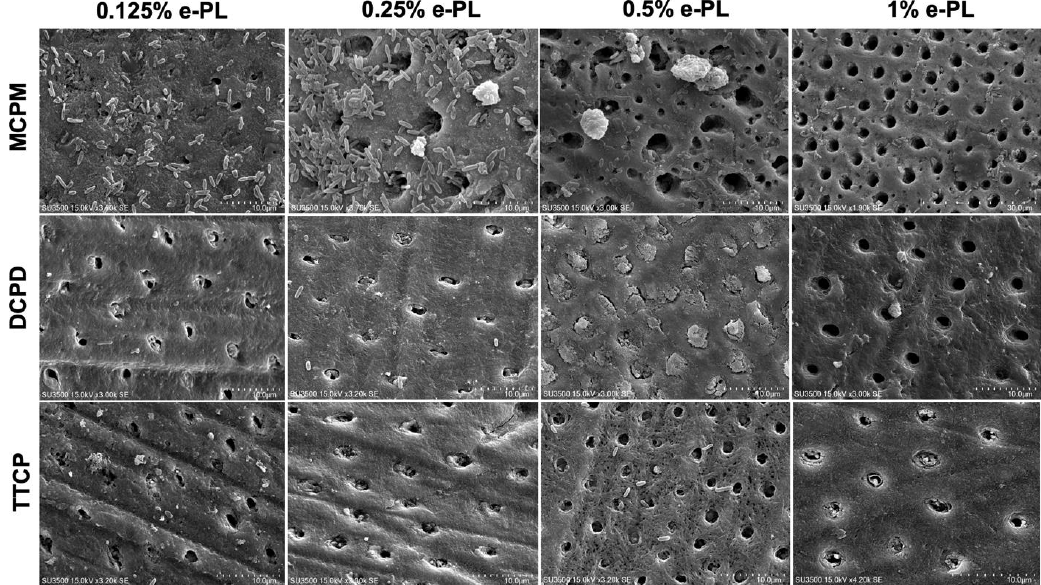
Figure 5. SEM images of the dentin tubule occlusion and bacterial inhibition on the P. gingivalis dentin surface after CPP and ε -PL application.